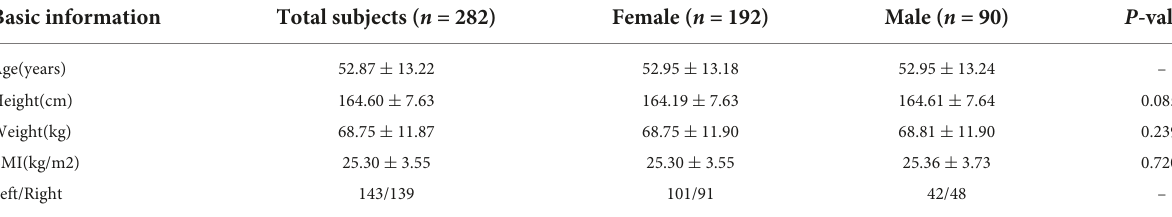
TABLE 1 Patient demographics (mean ± s.d.).